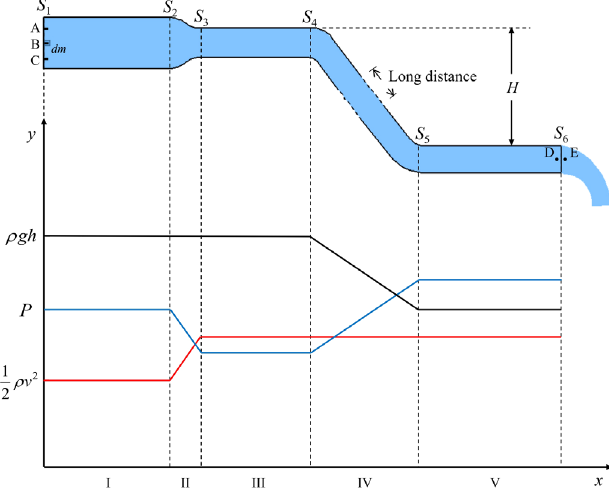
ρ v 2 in different 2